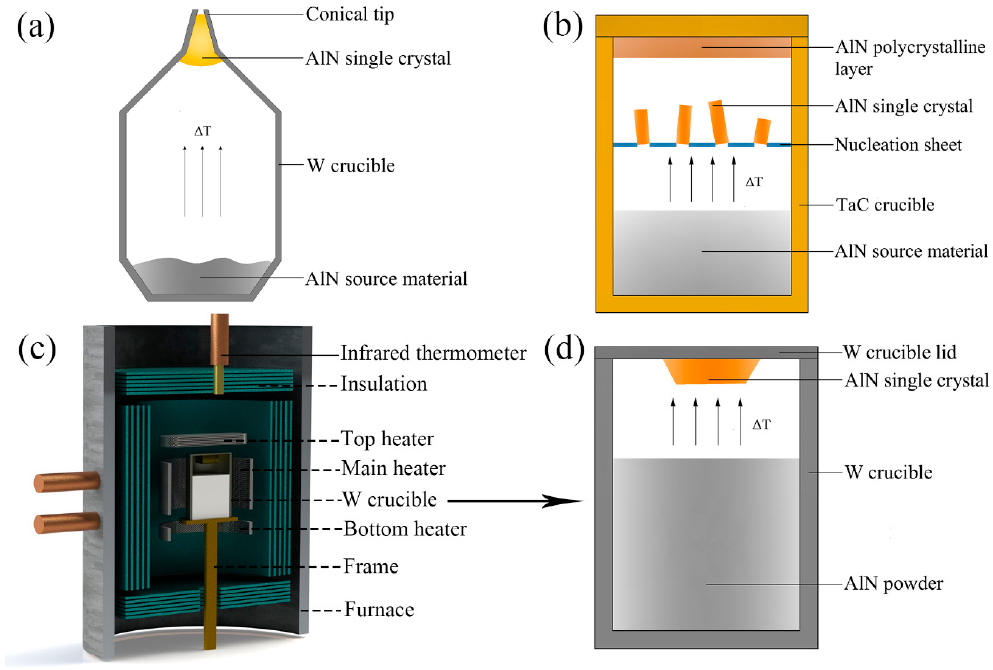
Figure 2. Schematic diagrams of three different growth setups: ( a ) A tungsten crucible with a conical tip designed for selected growth [28]. ( b ) A TaC crucible with a perforated sheet designed for separate freestanding growth [26]. ( c ) A growth unit with three heated zones. ( d ) A tungsten crucible deposited in setup ( c ) for the inverse temperature-gradient method.